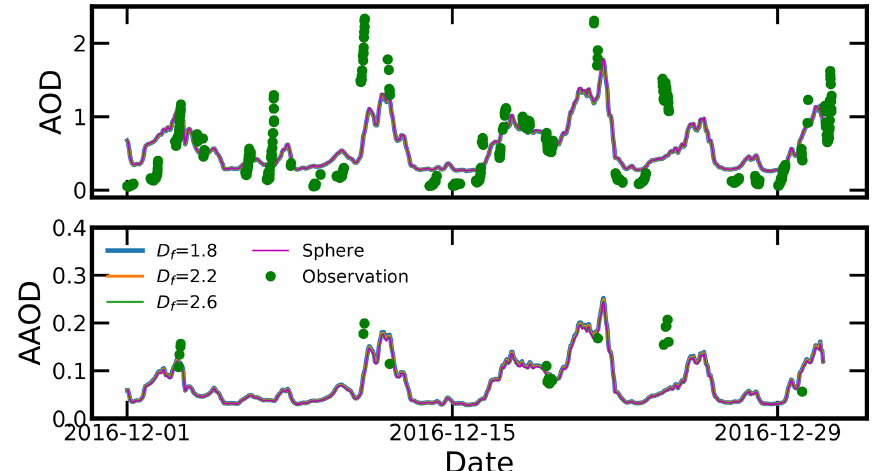
Figure 4. Comparison of measured and calculated AOD and AAOD in Beijing, where λ = 500nm for AOD. λ = 440 and 450nm for measured and calculated AAOD, respectively, and the observations were obtained from